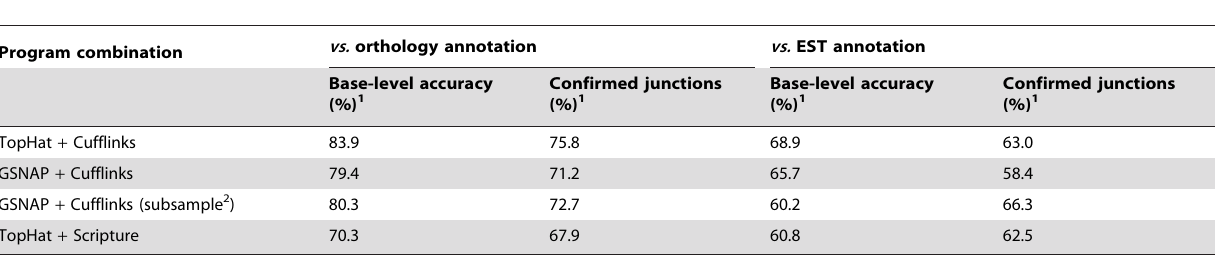
Table 1. Comparison of reference-based